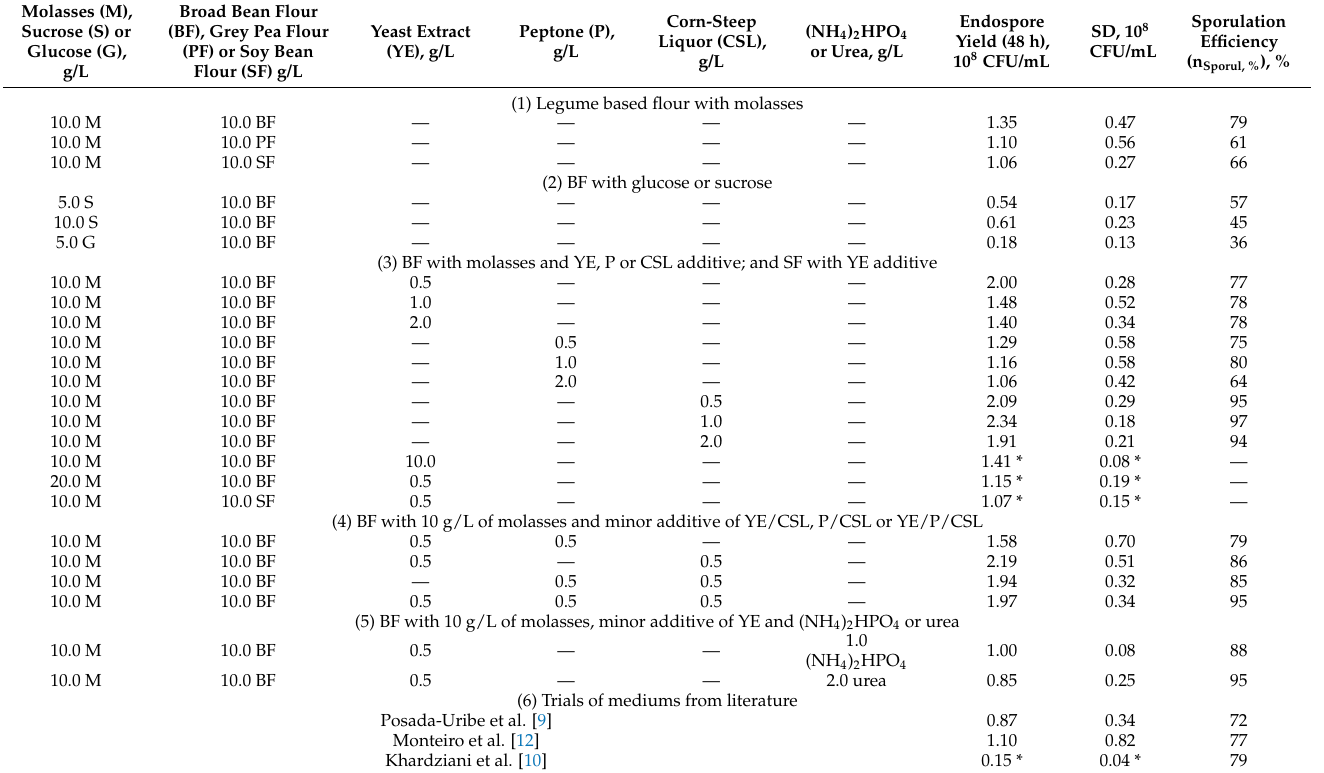
Table 1. Overview of the Bs medium composition investigation steps (1–6) and spore productivity